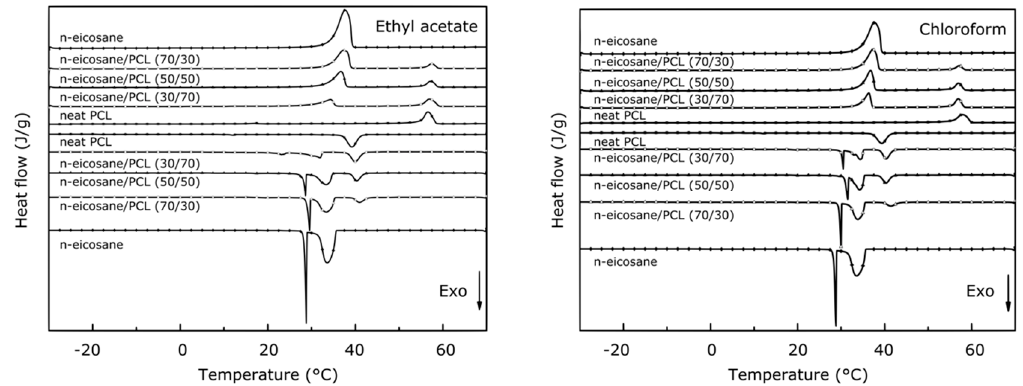
Figure 4. Differential scanning calorimeter (DSC) cuves of n -eicosane, neat PCL microspheres and a series of n -eicosane/PCL microcapsules obtained from different solvents with different mass ratios between n -eicosane and PCL.